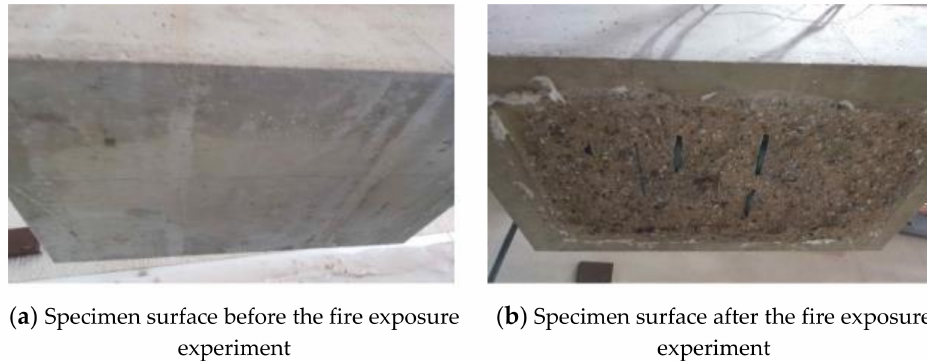
Figure 10. Specimen surface before and after the RABT-ZTV (railways) fire experiment.